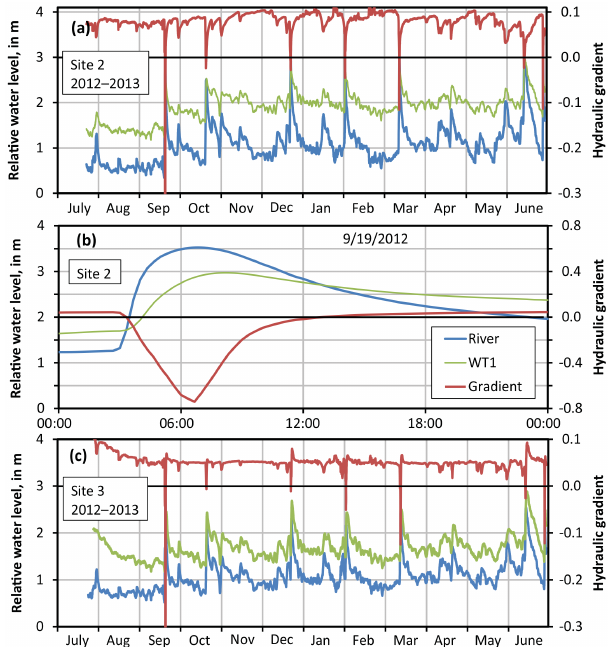
Figure 6. River stage, water-table elevation, and hydraulic gradient at sites 2 and 3. Legend in panel (b) also applies to panels (a) and (c) except site 3 data are from the WT2 monitoring well. (a) Site 2, July 2012 through June 2013; (b) 20min data from site 2 show- ing gradient reversal on 19 September 2012; (c) site 3, July 2012 through June 2013.